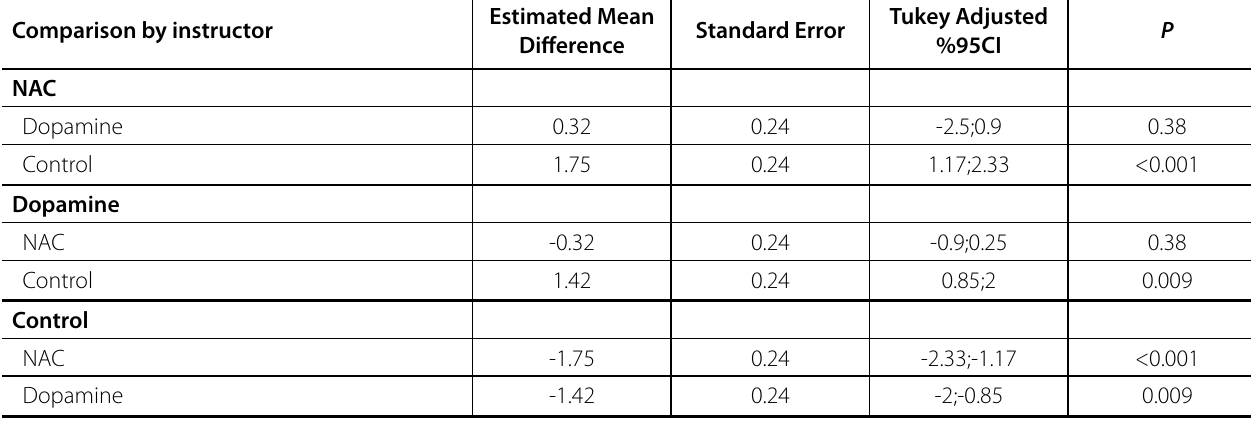
Table 5. Postoperative day 2. Post-hoc evaluation of eGFR with Tukey HSD.